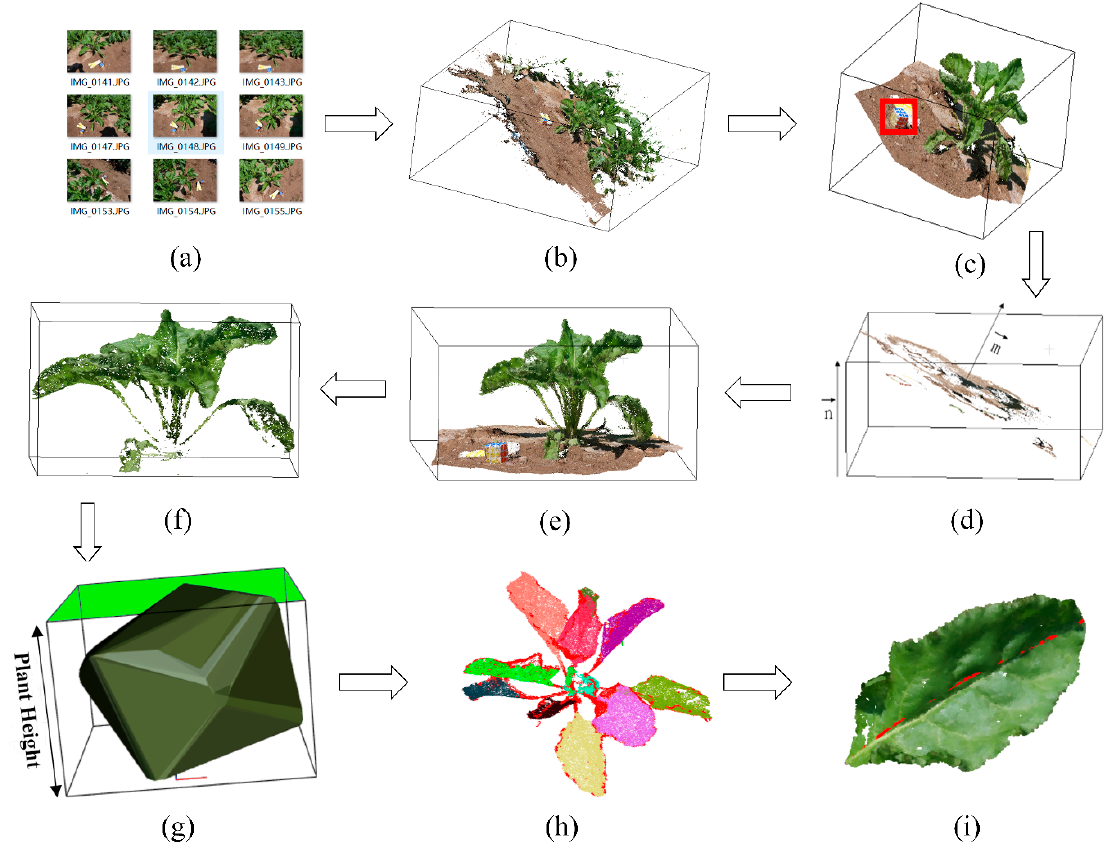
Figure 2. Data process flow: ( a ) Multi-view image set of sugar beet in the field; ( b ) Reconstructed point cloud of sugar beet population; ( c ) Individual point cloud of sugar beet. The red square is the magic cube; ( d ) Extracted point cloud of ground plane, 𝑚(cid:4652)(cid:4652)⃗ represents the normal vector of ground plane and 𝑛(cid:4652)⃗ stands for unit vector of z-axis; ( e ) Point cloud of sugar beet after coordinates correction; ( f ) Point cloud of sugar beet after filtering; ( g ) Plant structure extraction of sugar beet, green part means maximum canopy area; ( h ) Point cloud of sugar beet after segmentation; ( i ) Leaf structure extraction, the red line represents the extracted leaf length.